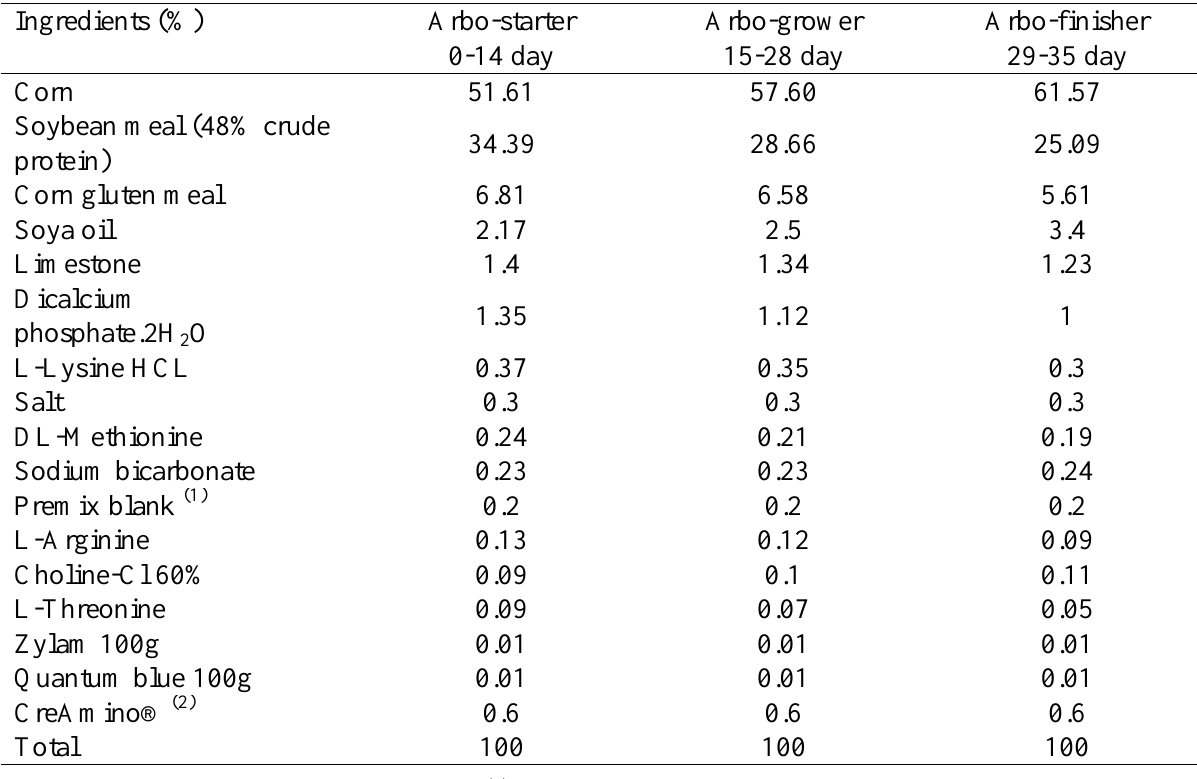
Table 1: Composition and calculated nutrients profile of the basal diet used in